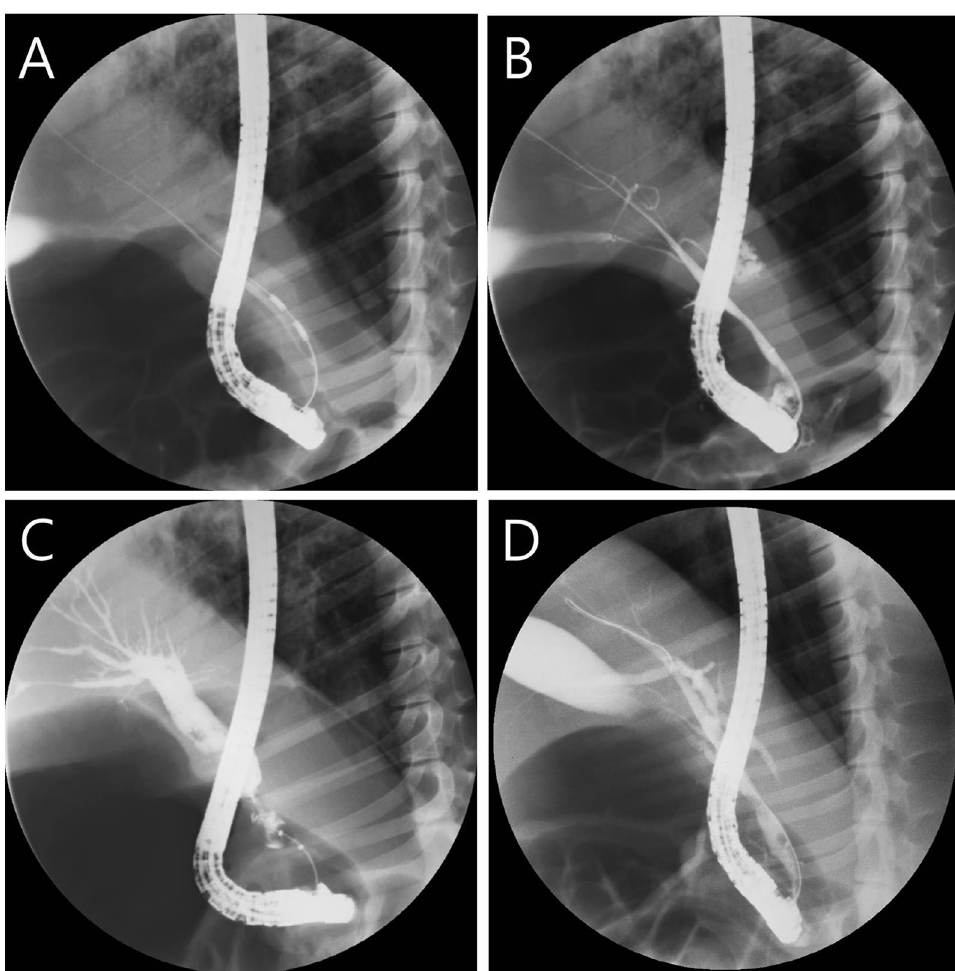
Figure 4. Endoscopic retrograde cholangiogram of miniature pigs. ( A ) Endobiliary RFA was performed in the distal common bile duct. ( B ) Immediate post-RFA cholangiogram showed no contrast leakage. ( C ) Follow-up cholangiogram at four weeks showed adequate post-RFA biliary stricture and definite upstream duct dilation. ( D ) Another representative follow-up cholangiogram at four weeks showed inadequate post-RFA biliary stricture and mild upstream duct